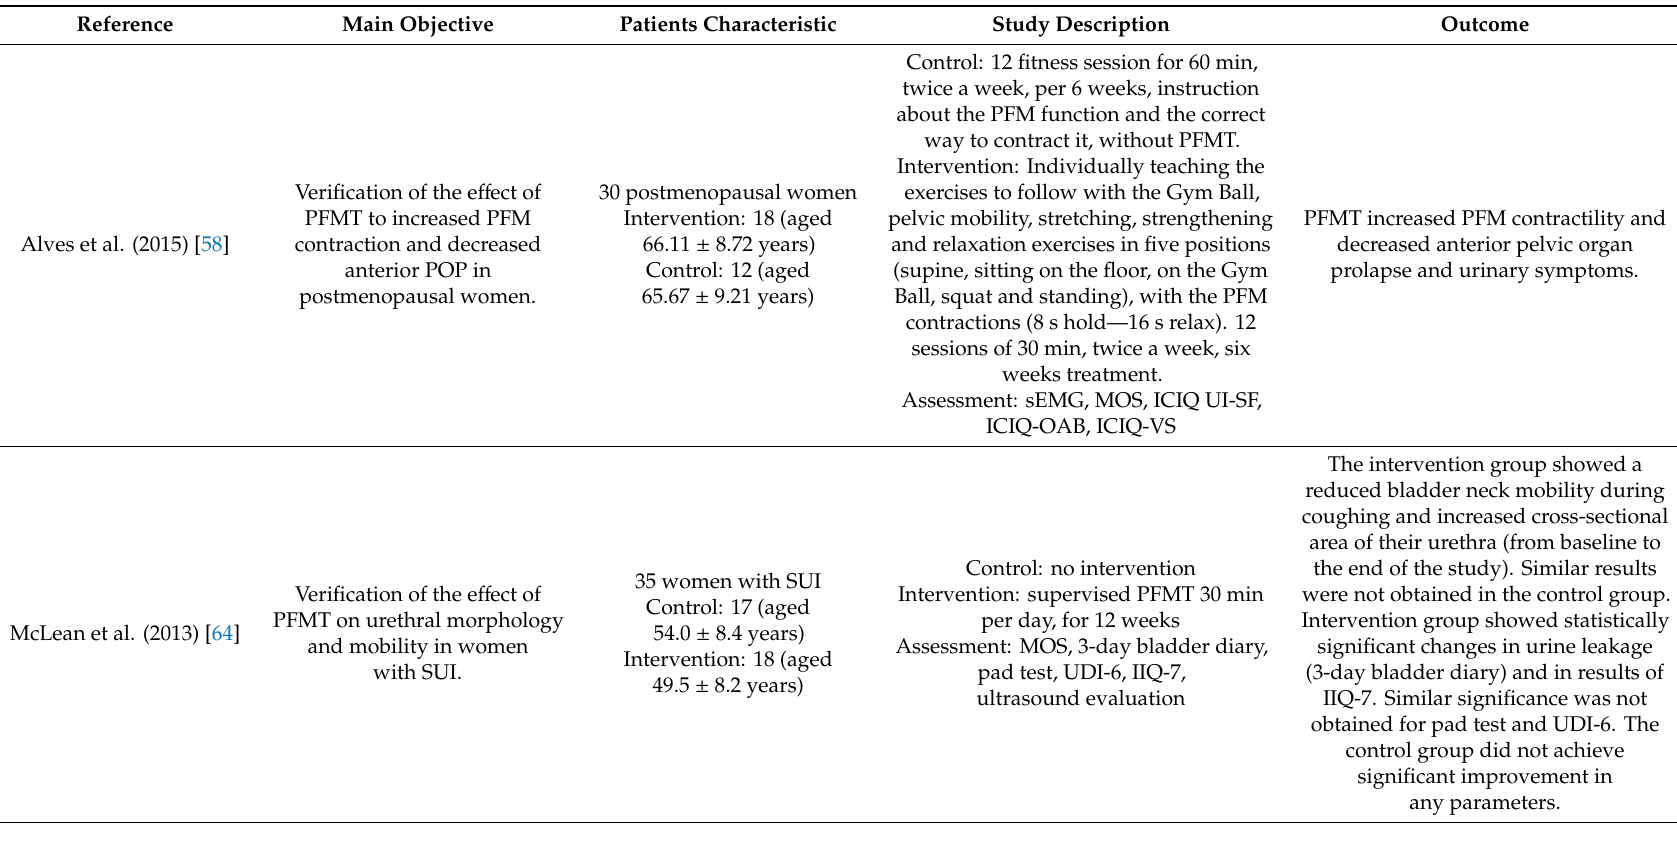
Table 1. Characterization of selected studies on the e ff ects of pelvic floor muscle training on the pelvic floor muscles (PFM) activity and / or severity of urinary incontinence